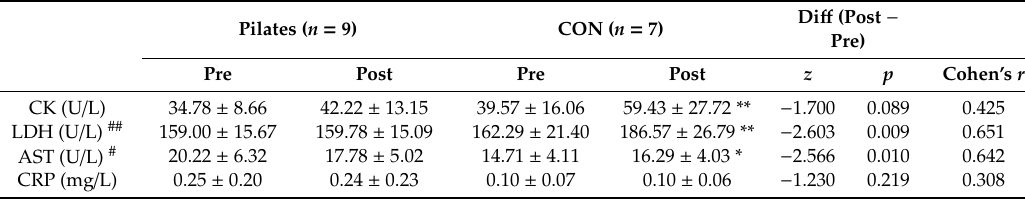
Table 4. Muscle damage and inflammation marker.